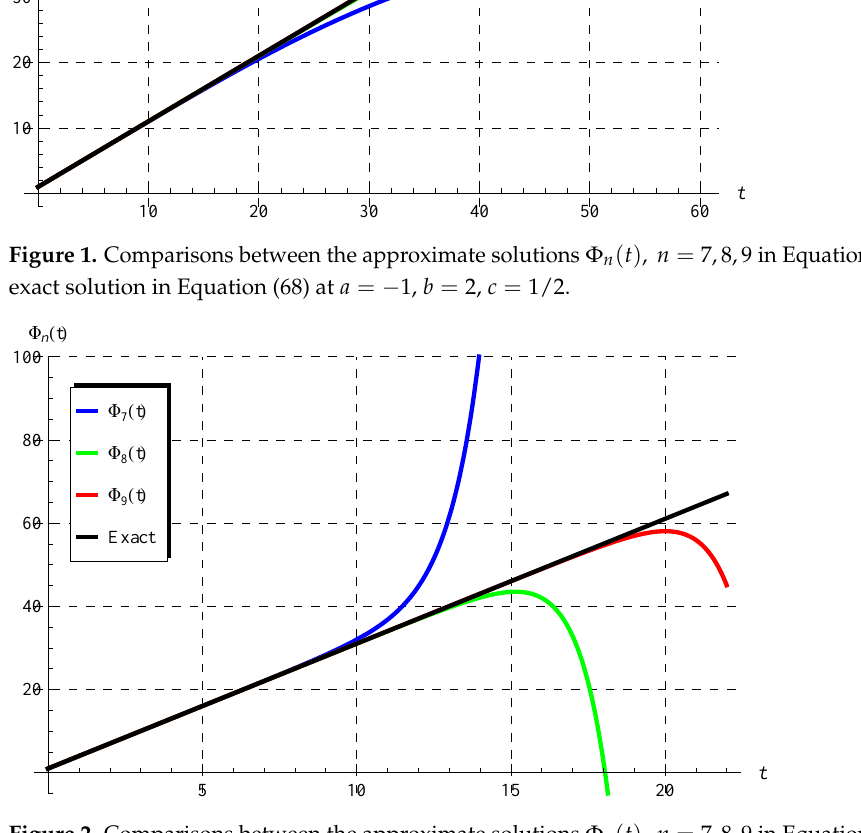
Figure 2. Comparisons between the approximate solutions Φ n ( t ) , n = 7,8,9 in Equation (67) and the exact solution in Equation (68) at a = 1, b = 2, c = −